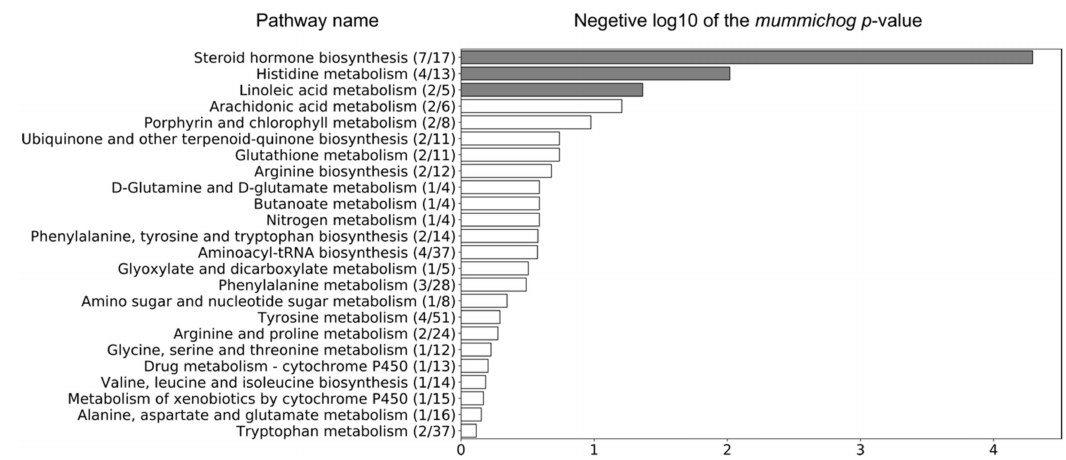
Figure 3. Three metabolic pathways were significantly altered in the LPS group between day 0 and 9, based on the 3132 ions that were obtained by pre-filtering the data (VIP > 1) using the associated OPLS-DA model (grey bars represent significantly altered metabolic pathways, p -value < 0.05). The ratio in brackets represents the number of significant matches to the total number of reported metabolites in the